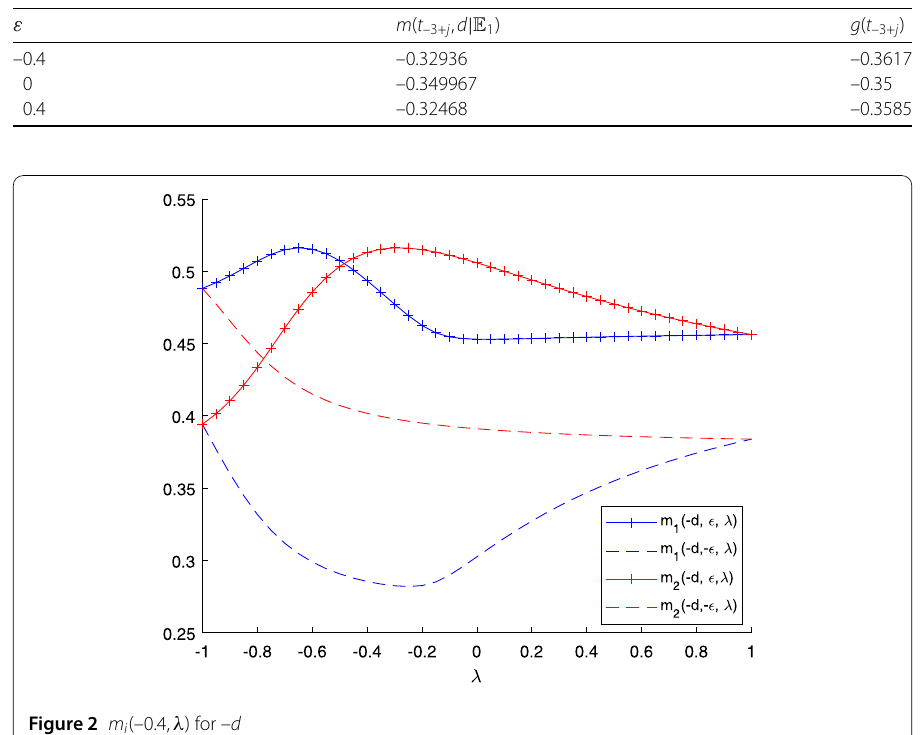
Table 1 Optimal